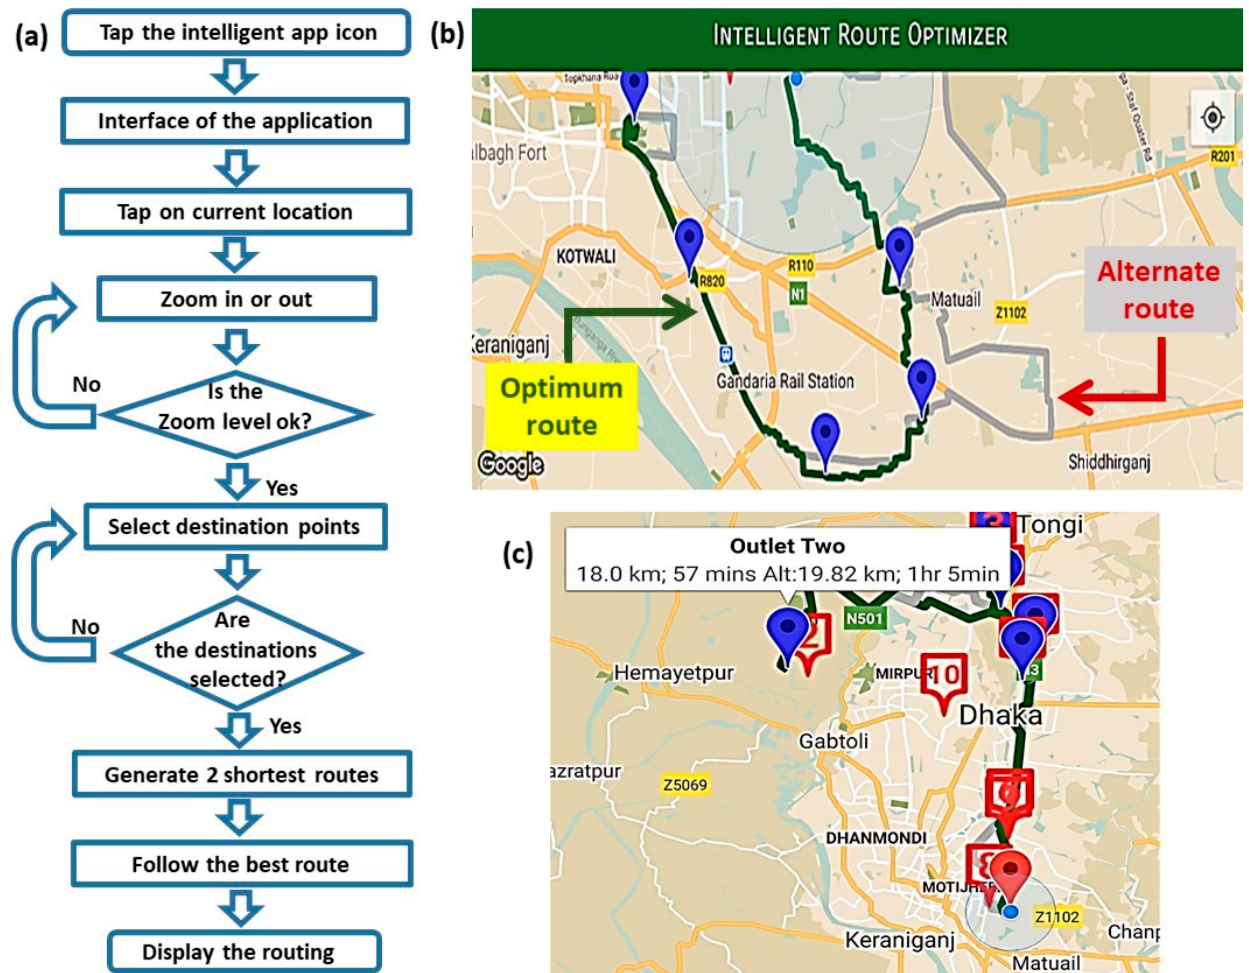
Figure 10. Illustration of ( a ) operation flowchart of intelligent route optimizer ( b ) journey routing showing optimum and alternate route option on Google Map ( c ) information showing distance and time of optimum and alternate routing to reach outlet two.